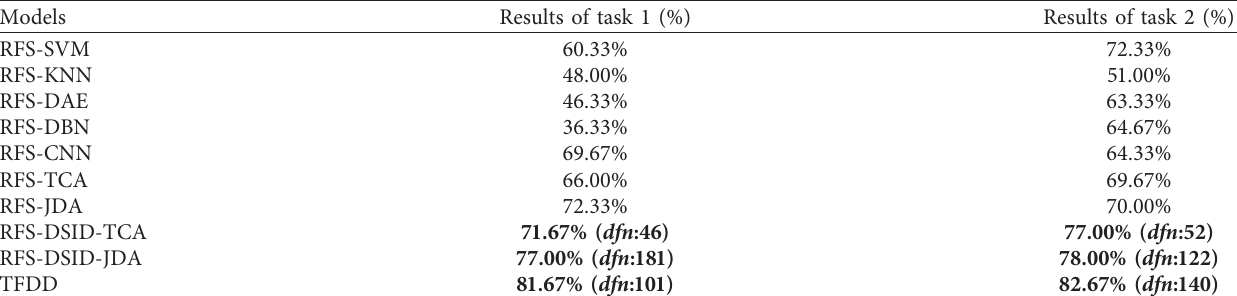
Table 6: Cross-domain fault diagnosis results of comparative models.